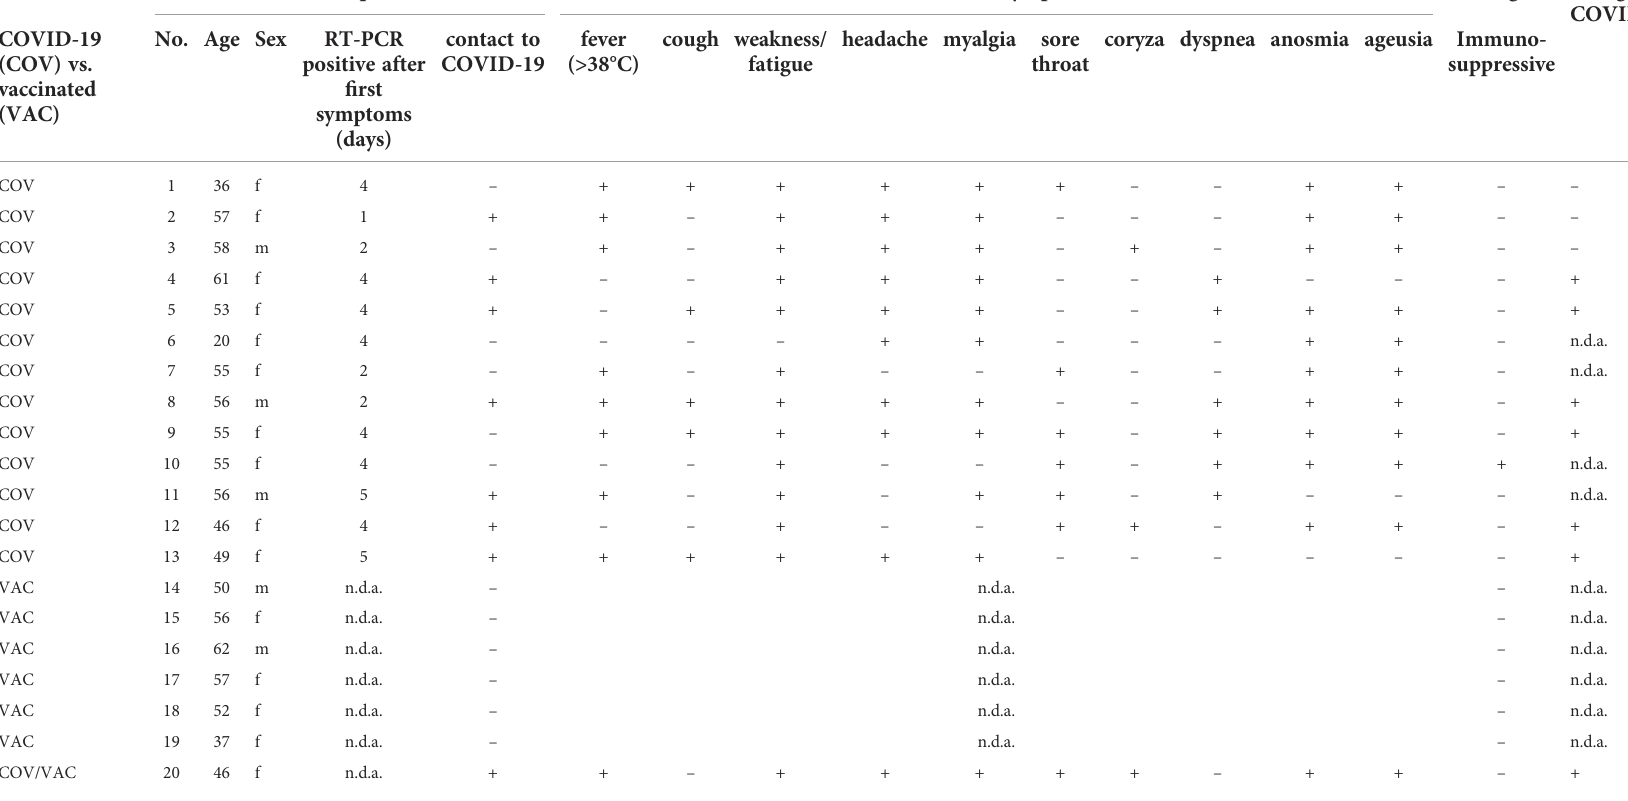
TABLE 2 Medical background of participants recovered from mild COVID-19 (No. 1 -13) and of vaccinated participants (No. 14 -